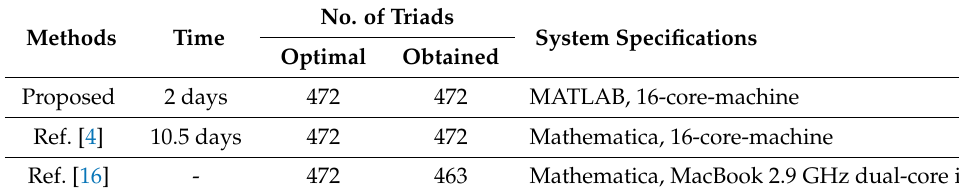
Table 1. Number of irreducible triads for aspect ratio f = 1.